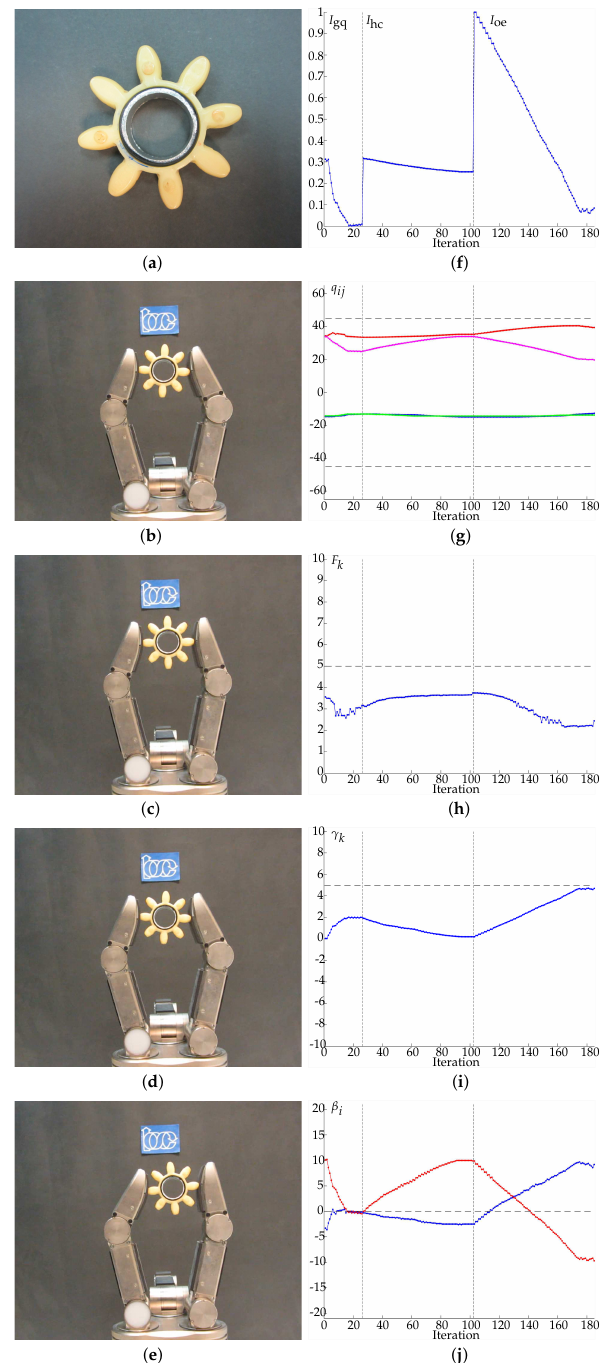
Figure 13. Example 3. ( a ) Manipulated object. ( b ) Initial grasp. ( c ) Hand configuration after optimizing I gq . ( d ) Hand configuration after optimizing I hc . ( e ) Hand configuration after optimizing I oe . ( f ) Evolution of the quality indexes. The manipulations improving I gq , I hc and I oe ended after 2.439 s and 26 iterations, 4.627 s and 75 iterations and 8.779 s and 82 iterations, respectively. ( g ) Evolution of the joints values in degrees, q 11 in blue, q 12 in red, q 21 in green, q 22 in magenta. ( h ) Average force F k in Newtons, the dashed line indicates F d . ( i ) Evolution of the object orientation in degrees. ( j ) Angles β i in degrees, β 1 in blue and β 2 in red (the dashed line indicates the optimal value of β i ). Note that, due to the shape of the manipulated object, the contact is produced on a limited region of the sensor and therefore the force F k cannot reach the desired force F d